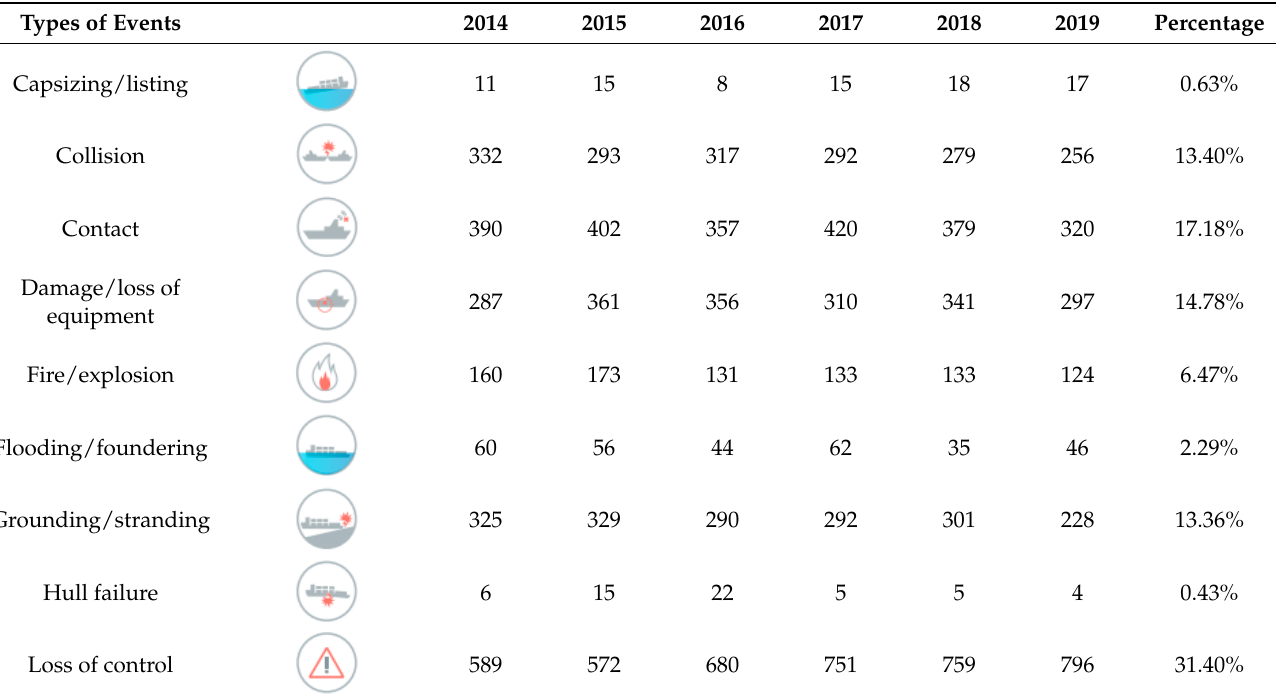
Table 1. Distribution of casualty events with a ship.